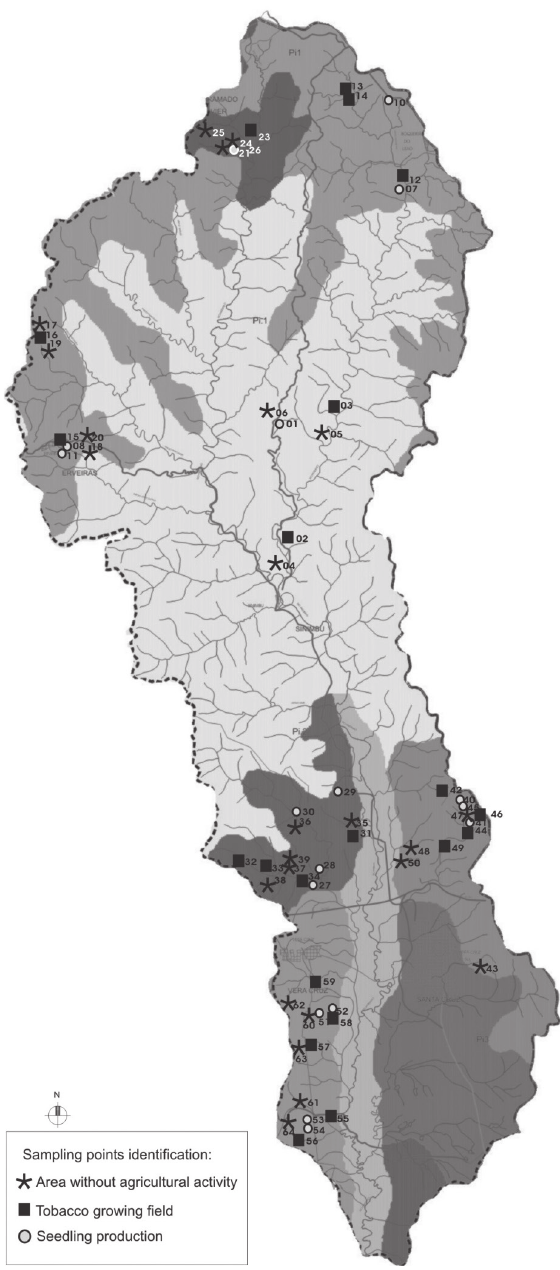
Figure 2 - Soil sampling points. H AIR S